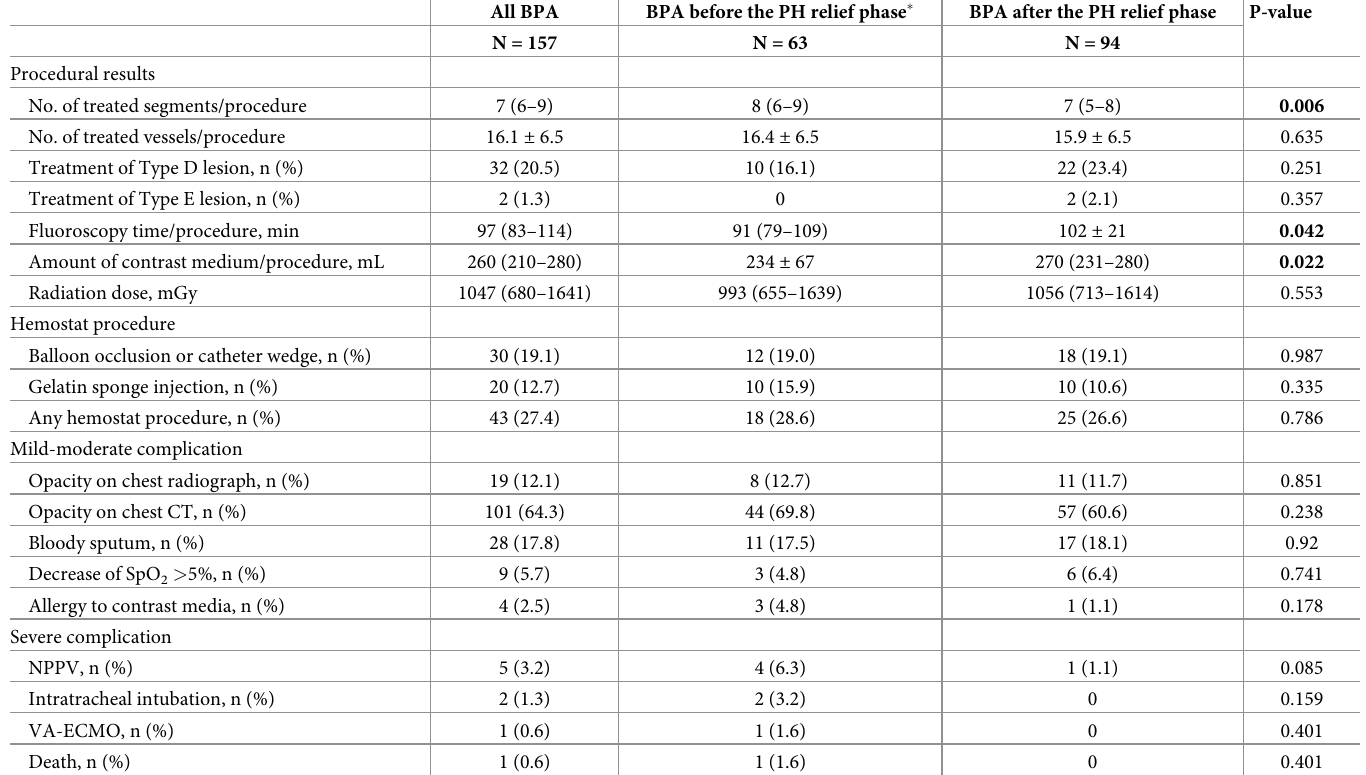
Table 2. Comparison of procedural results and complications for each session of balloon pulmonary angioplasty. All